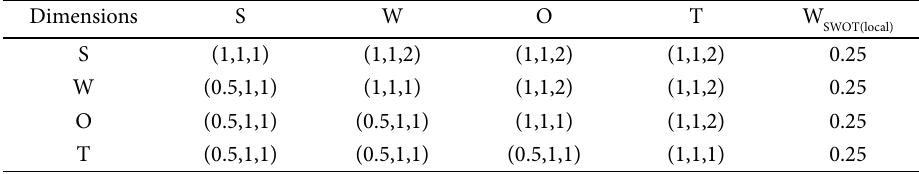
Table 2. Pair-wise comparison matrix and weights of SWOT groups Dimensions